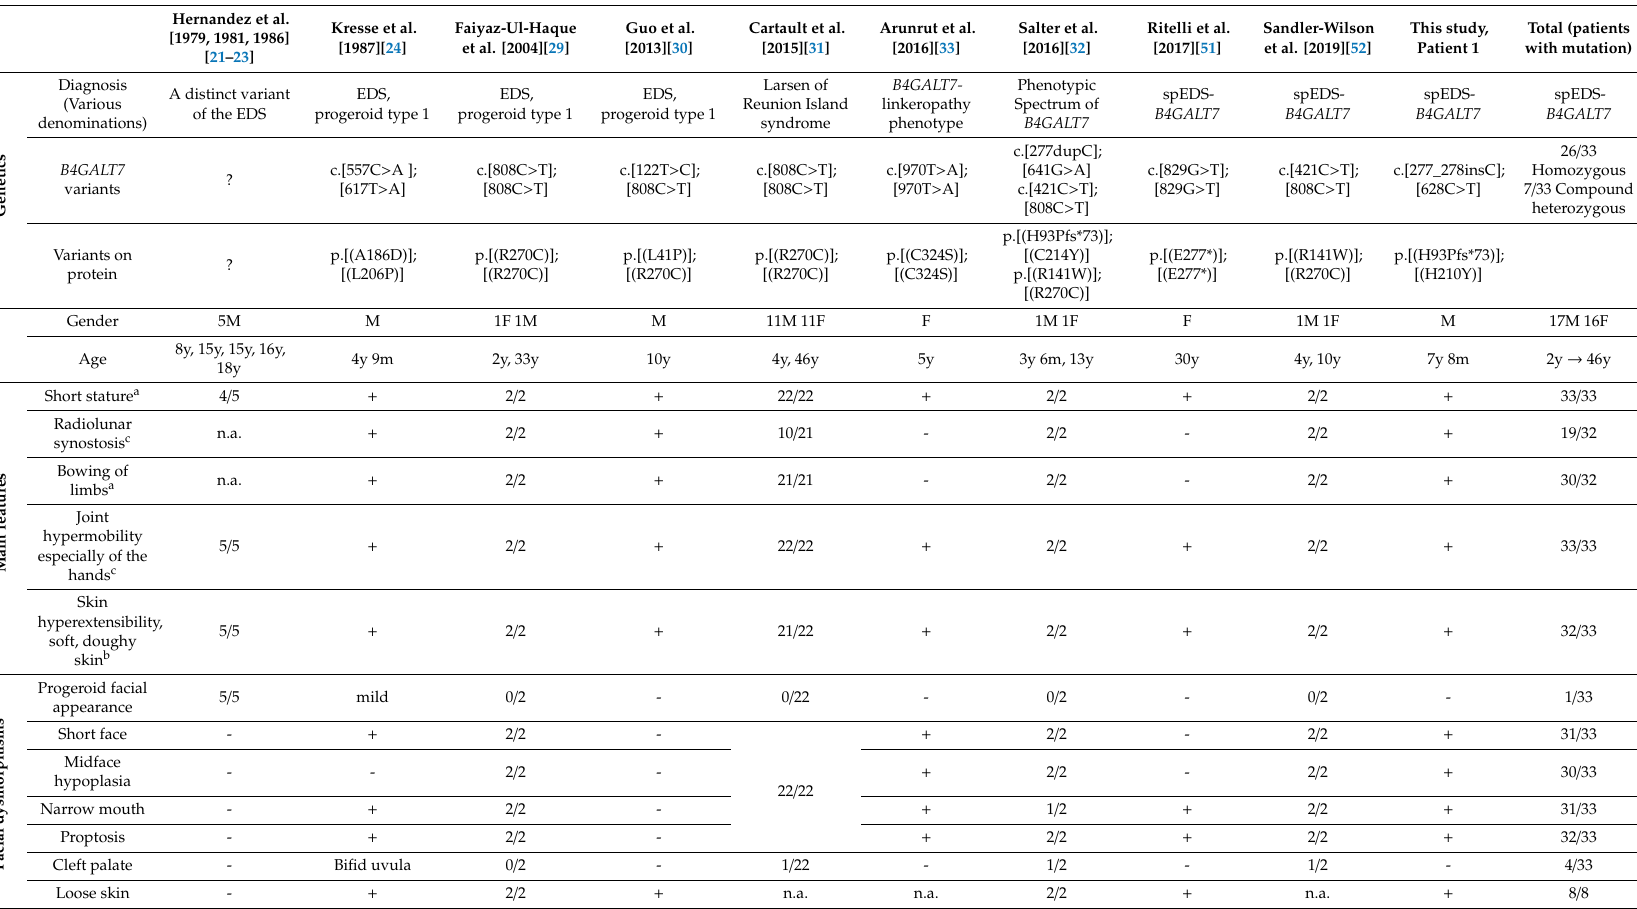
Table 1. Patients with B4GALT7 variants: Review of the literature.